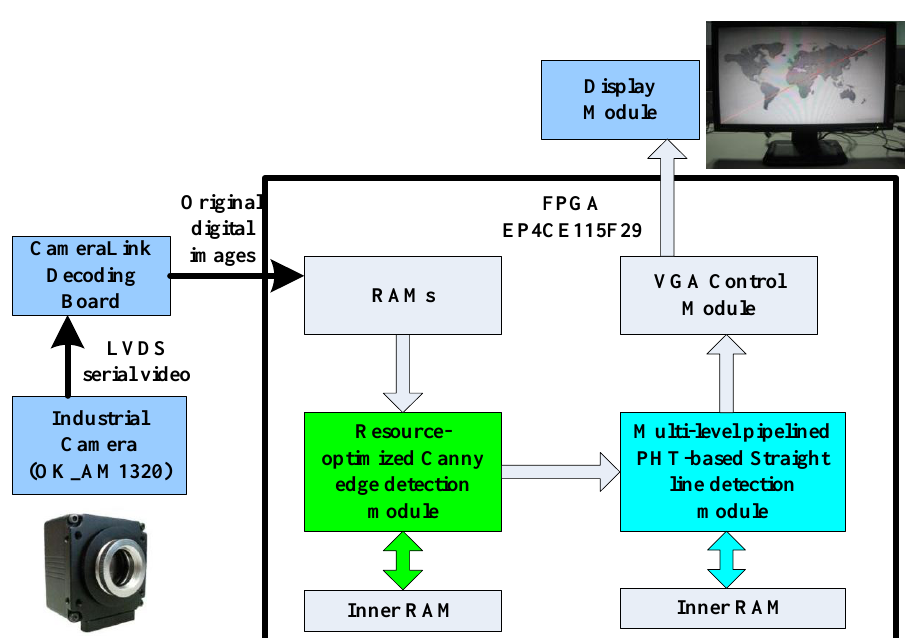
Figure 2. The block diagram of embedded straight line detection